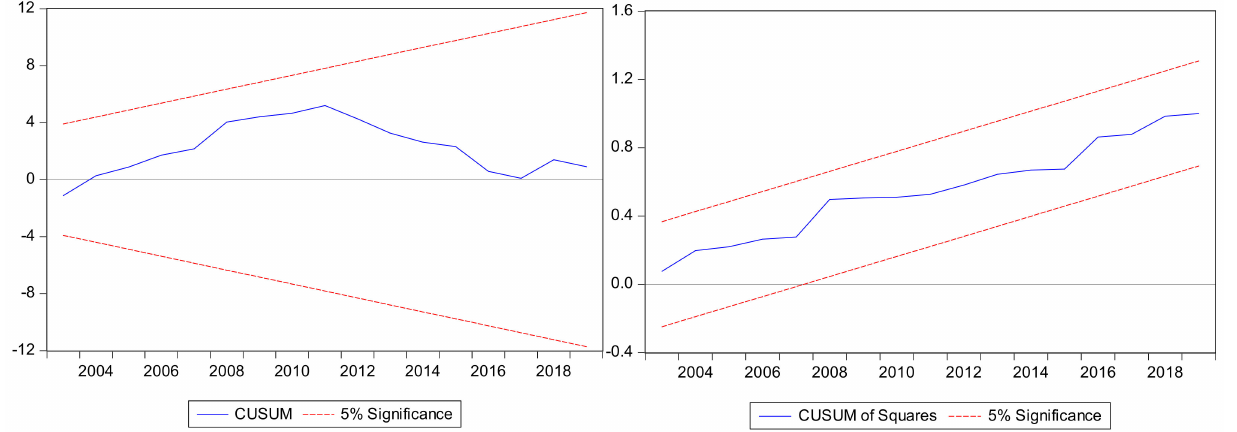
Figure 2. CUSUM and CUSUM square. Blue line is model line where as upper and lower red doted lines are upper and lower bounds. Model will be fit if blue line lies in between upper and lower bounds.